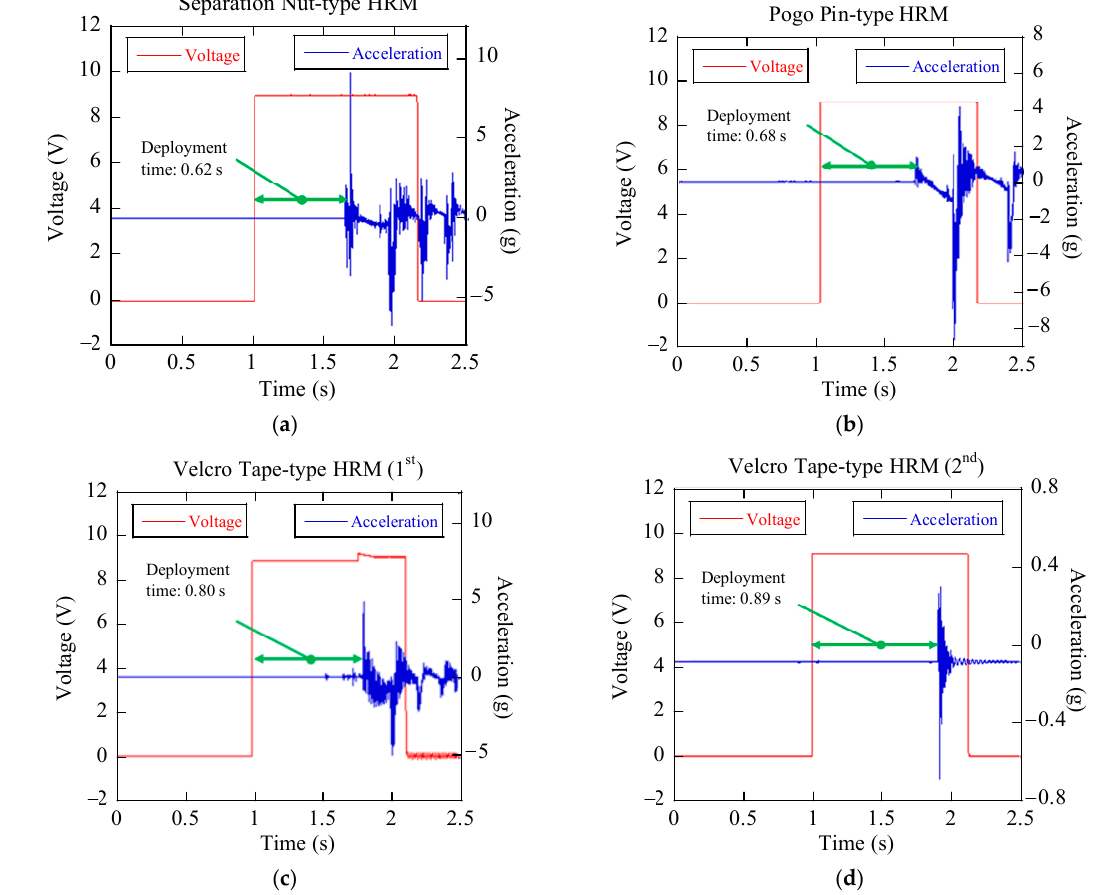
Figure 13. Time histories of the input voltage, separation signal, and acceleration response of the solar panels with the ( a ) separation nut-type HRM, ( b ) pogo pin-type HRM, ( c ) Velcro tape-type HRM (1st), and ( d ) Velcro tape-type HRM (2nd).